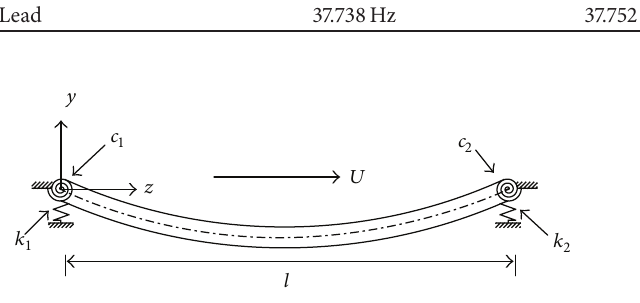
Figure 3: Schematic diagram of the fuel rod in axial flow.